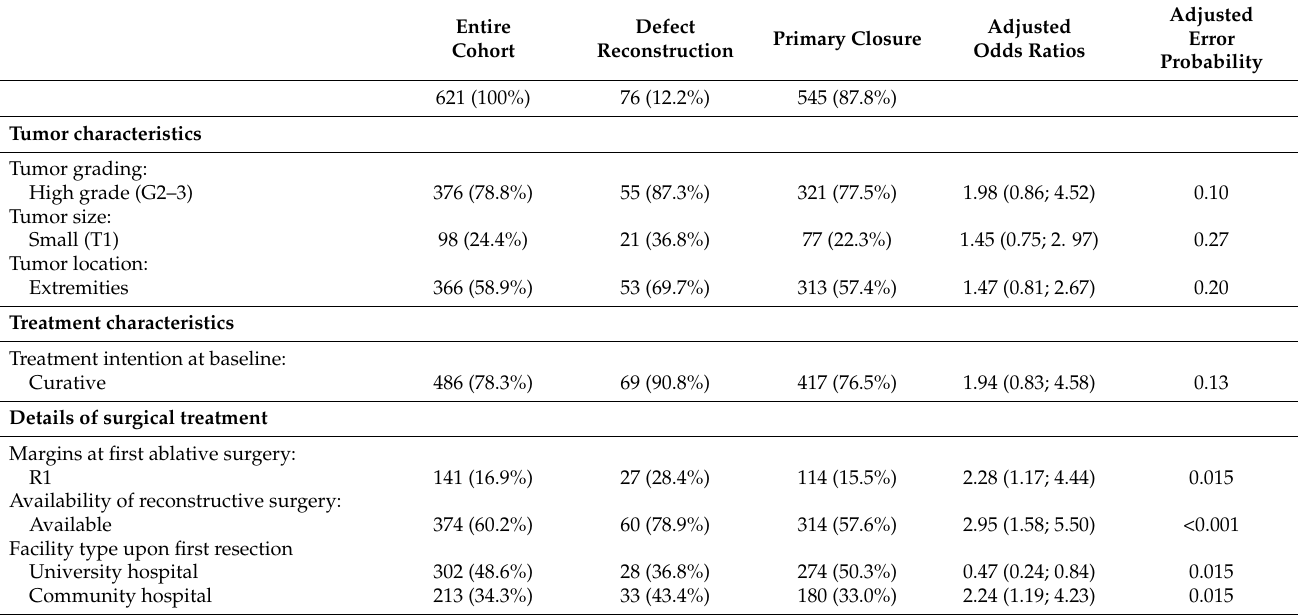
Table 5. Independent Predictors of Defect